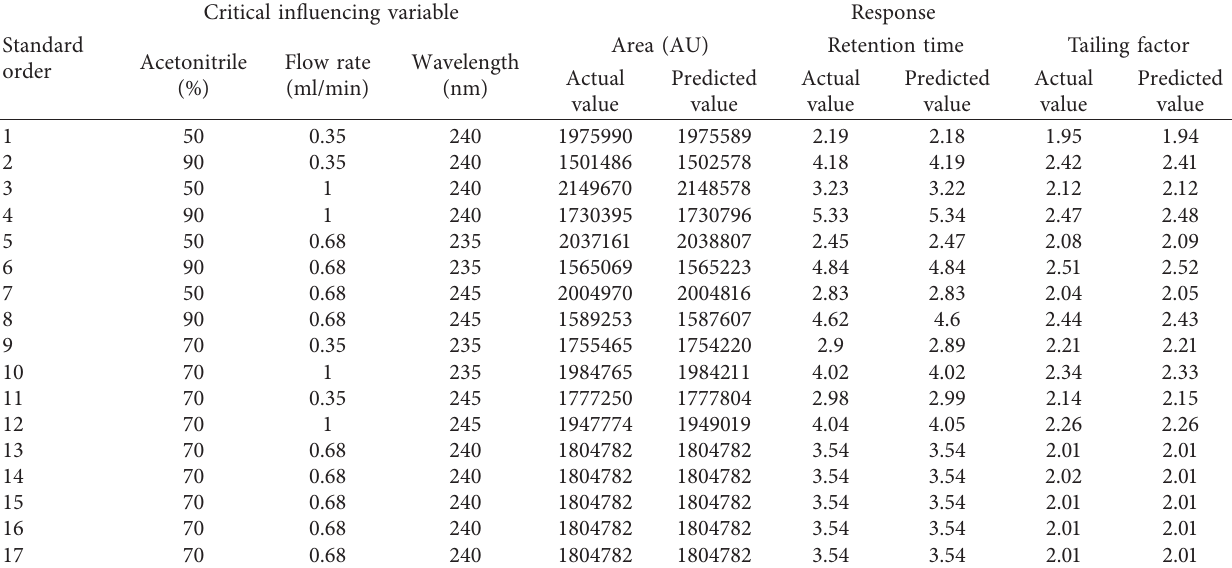
Table 2: Critical influencing variable and their actual and predicted values of